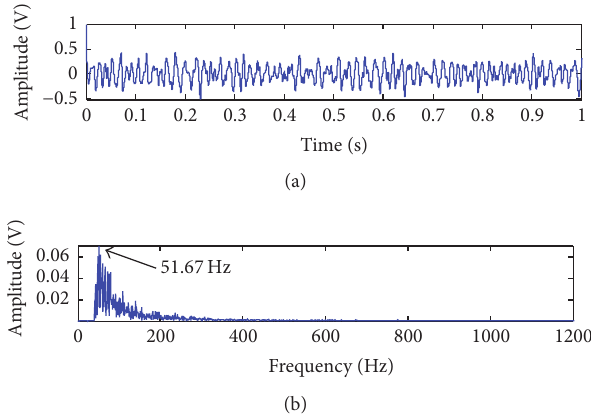
Figure 10: Optimal output signal of IMF4: (a) time-domain wave- form; (b) frequency